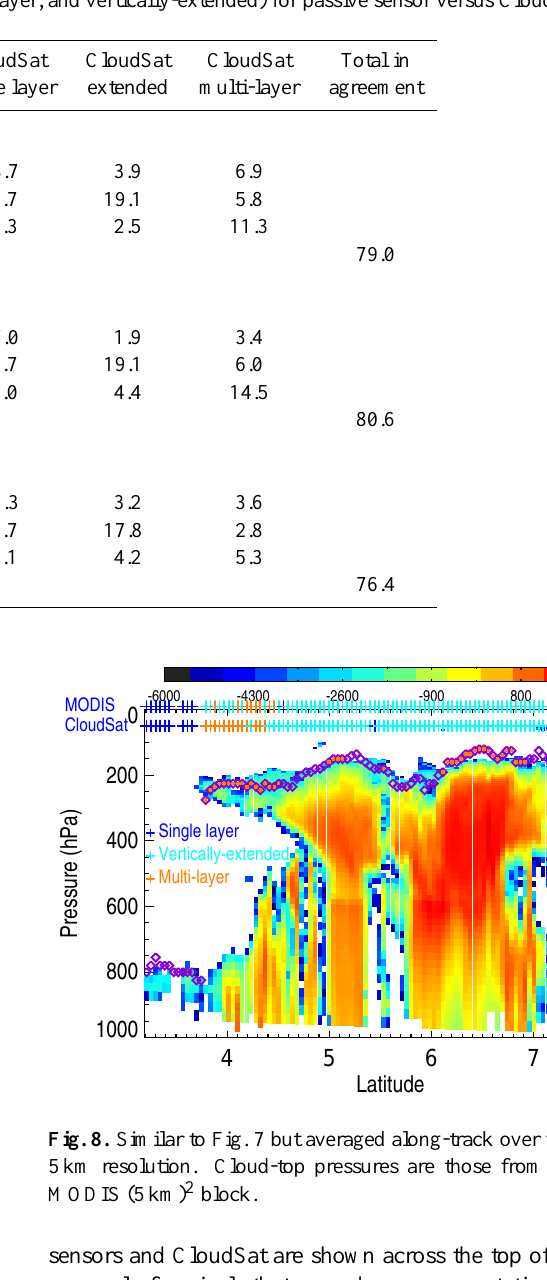
Table 2. Cloud classification statistics (single layer, distinct multi-layer, and vertically-extended) for passive sensor versus CloudSat (%).